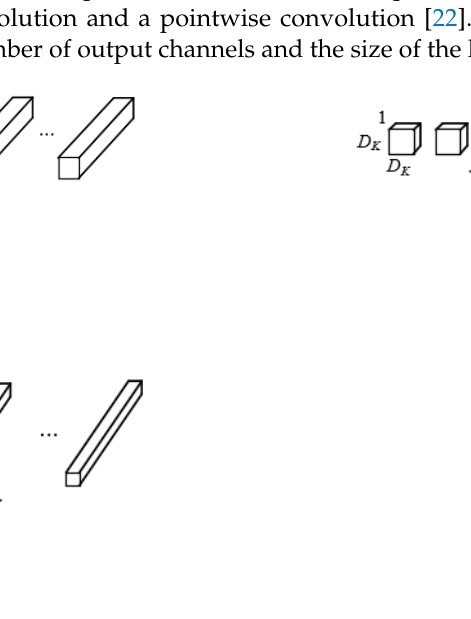
Figure 3. Schematic diagram of standard convolution and depth separable convolution. ( a ) Standard convolution process. ( b ) Depthwise convolution process. ( c ) Pointwise convolution process. Depthwise convolution in Figure 3b has a computational cost of: